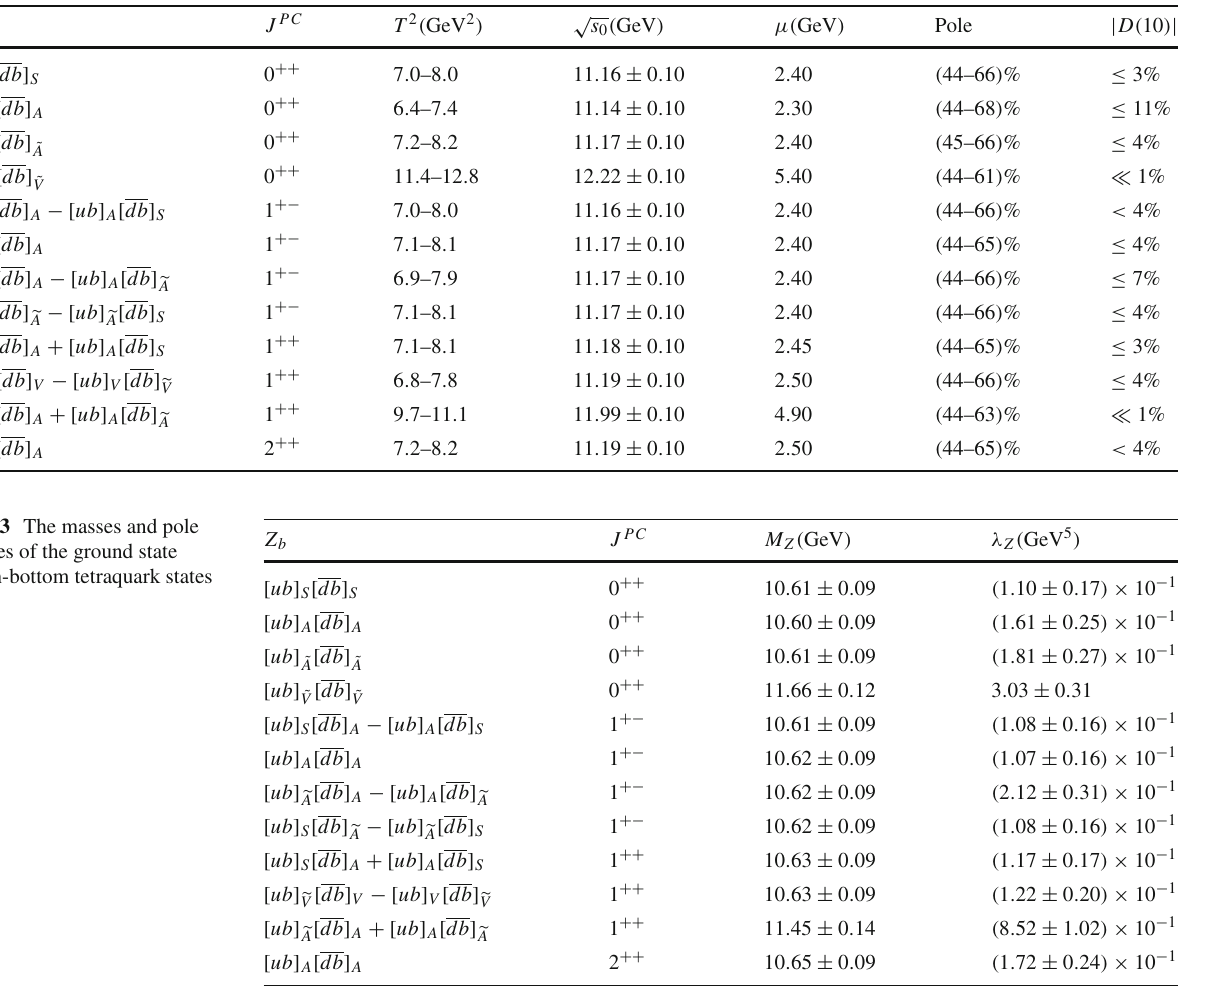
Table 2 The Borel parameters, continuum threshold parameters, energy scales of the QCD spectral densities, pole contributions, and the contribu- tions of the vacuum condensates of dimension 10 for the ground state hidden-bottom tetraquark states Z b J PC